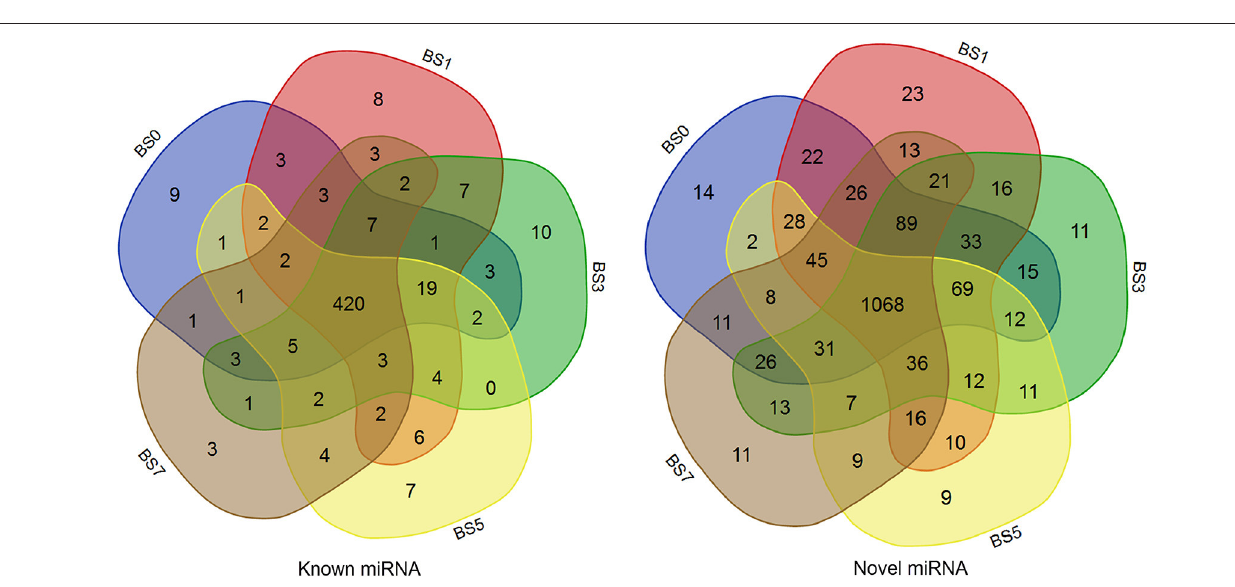
unconservative_3_22065 (5 ′ -aaaaaccugaaugacccuuuug-3 ′ ) was ( Table 4 , Supplementary Table 3 ). With the extension of